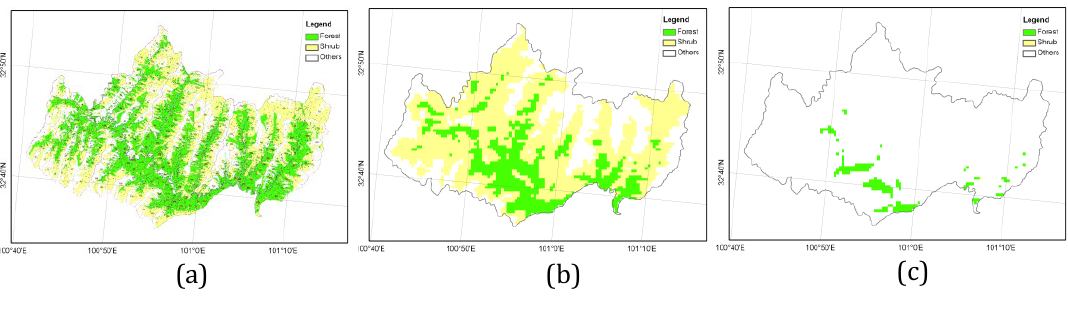
6. Vegetation distribution map from Makehe Forest Region located in Sanjiangyuan Nature Reserve: ( a ) 1:50,000 field survey; ( b ) hierarchical soft time-space classification; and ( c ) MODIS 2007 PFT product. Note that, closed/open forest (green) and closed/open shrub (yellow) of the 1:50,000 field survey is combined for a better comparison; related statistics are provided in Table 4.